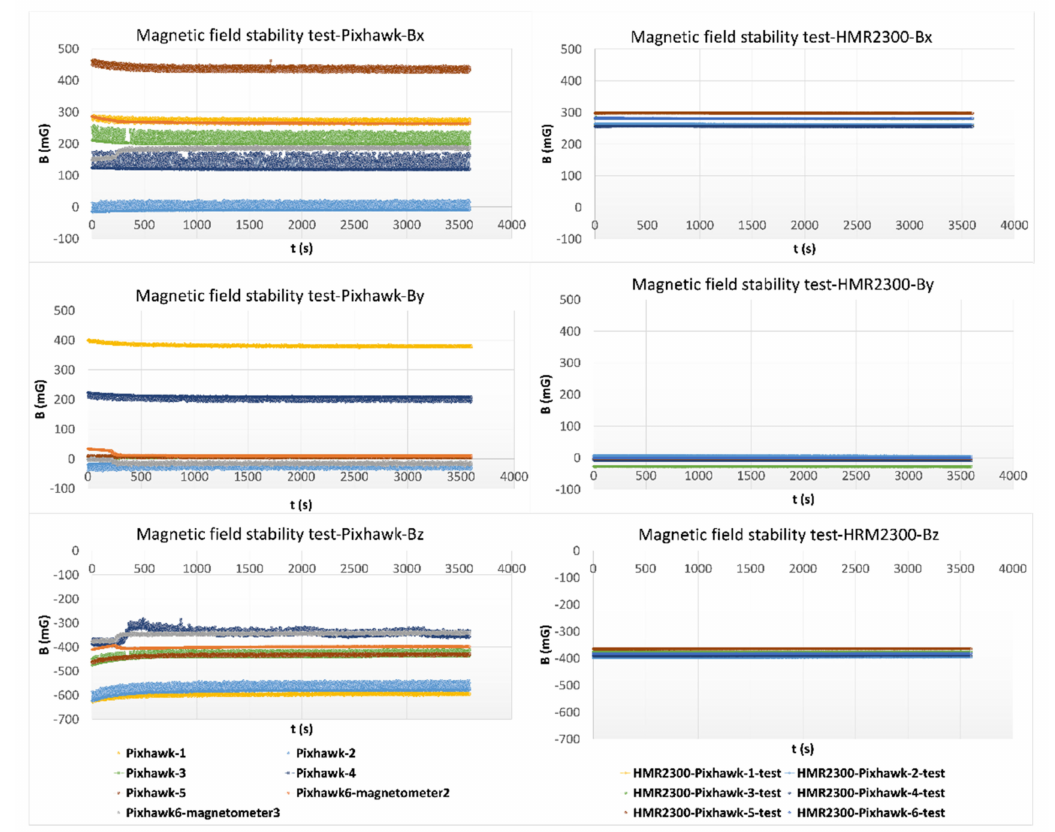
Figure 7. Magnetic field stability test results. B represents magnetic field, with Bx being the X -axis magnetic field, By the Y -axis magnetic field, and Bz the Z -axis magnetic field; t represents time. The peak-to-peak amplitude, considered as the difference between the maximum and minimum values measured by an instrument for the same conditions, also shows relevant information. This parameter is higher in the case of Pixhawk magnetometers than in the HMR2300 gaussmeter. For example, the worst value in terms of peak-to-peak amplitude considering the autopilot magnetometers was higher than 100 mG for Pixhawk-4, whereas the worst case for the HMR2300 gaussmeter was 5.4 mG. In a similar way, the maximum difference value was 25 mG for the Pixhwak-6 magnetometer-2, while this value only reached 1.3 mG for HMR2300 gaussmeter during the same test. A numerical comparison between the peak-to-peak amplitude for each Pixhawk and HMR2300 is collected in Table 3. The other result of this test is the greater time needed to stabilize the magnetic field value in the case of Pixhawk magnetometers, which can be appreciated in Figure 7. The time needed ranged between 9 and 17 min for stabilization, depending on autopilot and axis, whereas it was in the order of tenths of seconds for the HMR2300 gaussmeter. According to this, to increase the accuracy of the Pixhawk autopilot in terms of magnetic field measurement, it should be switched-on for at least 17 min before starting its operations. The magnetic field data obtained were measured directly from the magnetometers without applying any additional filtering or data